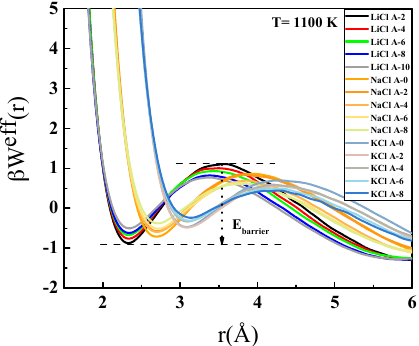
Figure 13. The potential of the mean force for breaking the A + -Cl − ‘bond’ in the various systems at 1100